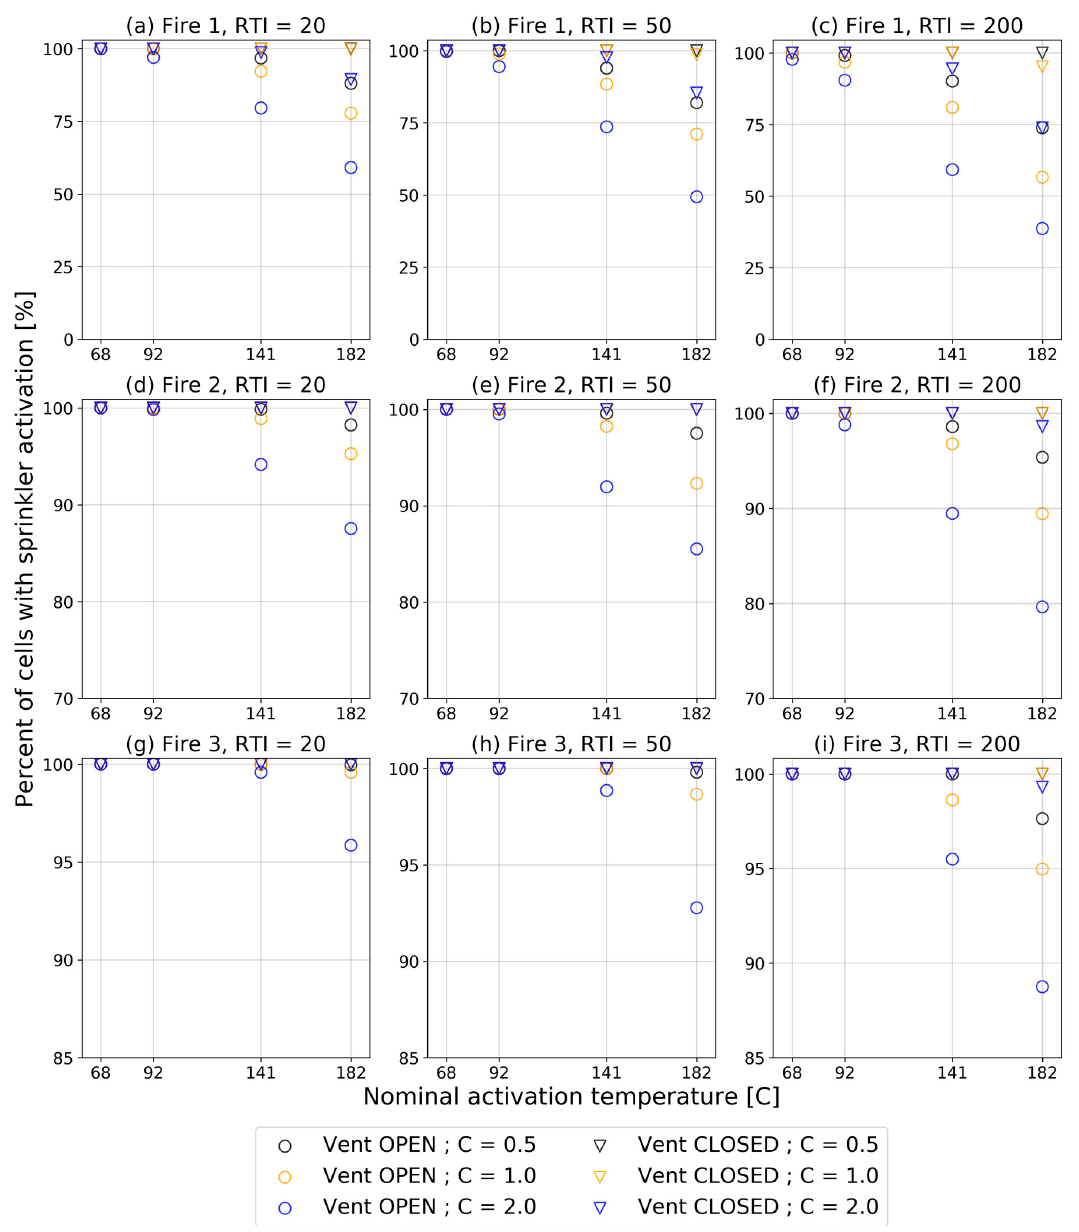
Figure 7. The percentage of the numerical cells in which the activation of sprinkler occurred within the simulation time (600 s) for different fire sources, response time index ( RTI) and C values. Different plots ( a–i ) represent different Fire scenarios (1-3) and different RTI values (20, 50 and 200), as described in the title above each plot.